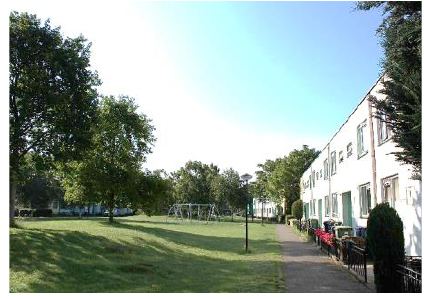
Figure 5. Green space in Regenboogbuurt: Location 1 (courtesy of Author 2).